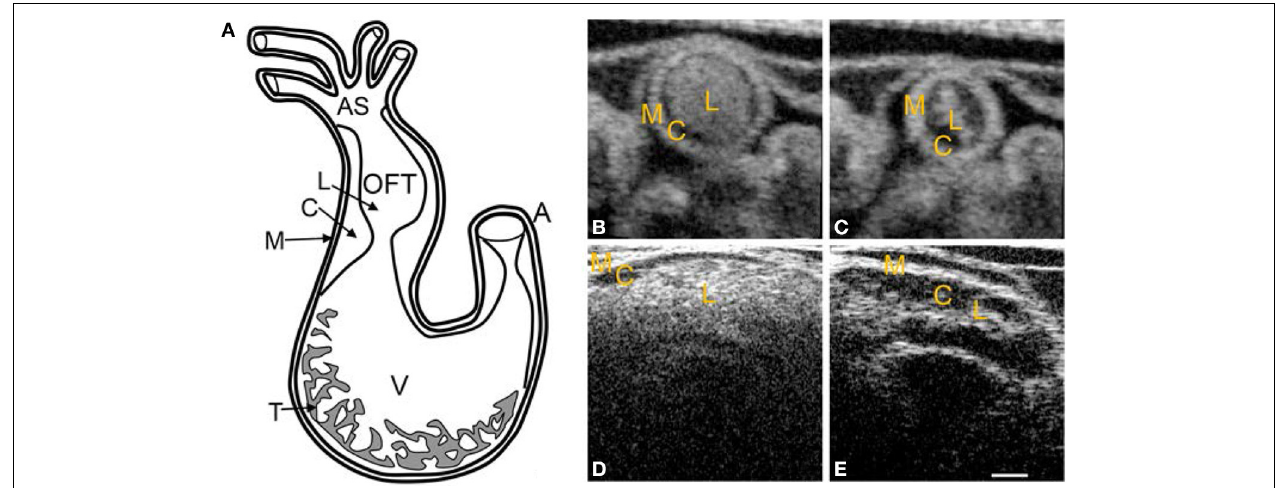
FIGURE 2 | Chick heart structure at HH18. (A) Heart schematic showing the outflow tract cushions at the inlet of the outflow tract. (B–E) Representative optical coherence tomography images of the outflow tract. Cardiac jelly appears darker in between the lighter myocardium and lumen. (B) Cross-sectional 2D image at maximal